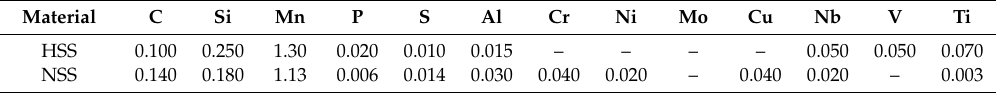
Table 1. Chemical composition of the steel